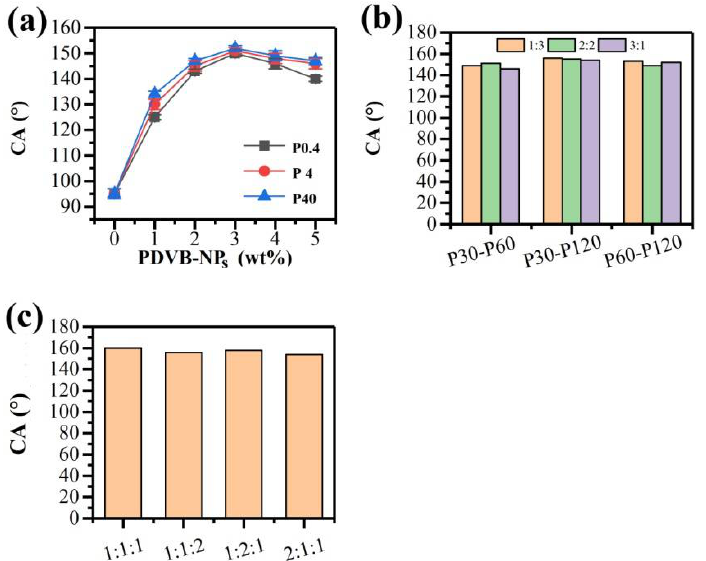
Figure 5. ( a ) CA of the superhydrophobic paper coated by one of P 40 , P 4 , and P 0.4 , ( b ) CA of the superhydrophobic paper coated by two of the three particles, and ( c ) CA of the superhydrophobic paper coated by three particles.